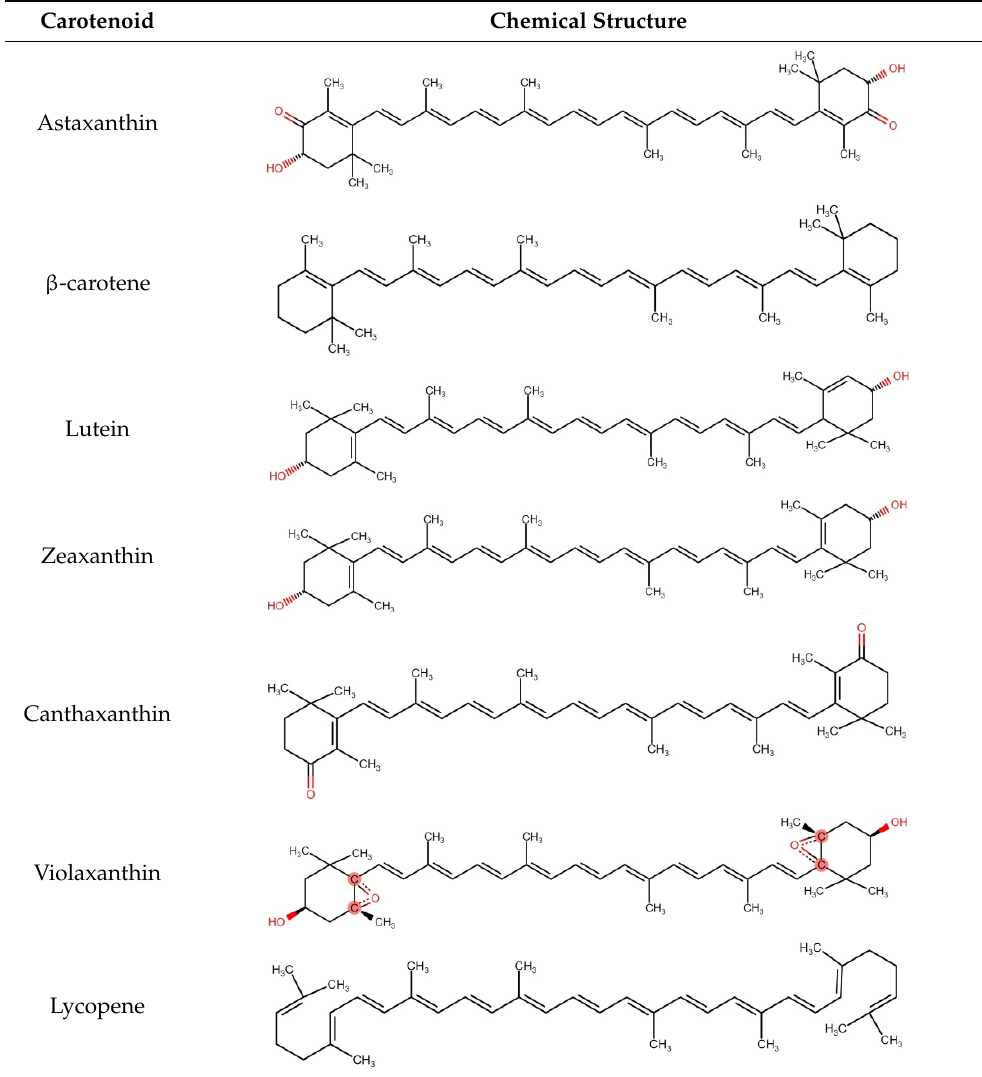
Table 1. The chemical structure of some common microalgal carotenoids.